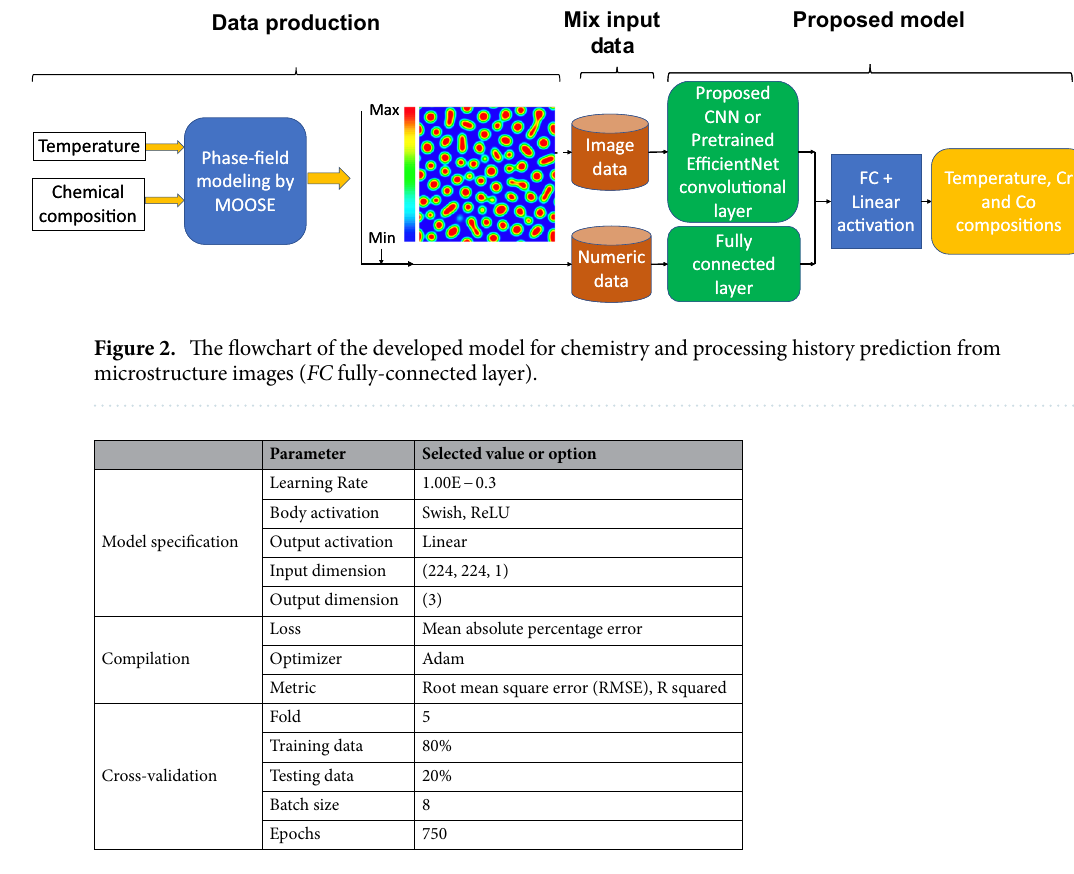
Table 2. Parameters selected for model specification, compilation, and